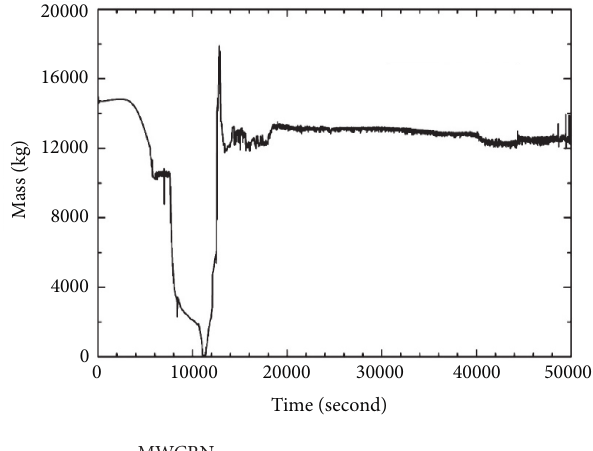
Figure 15: Mass of water in core.